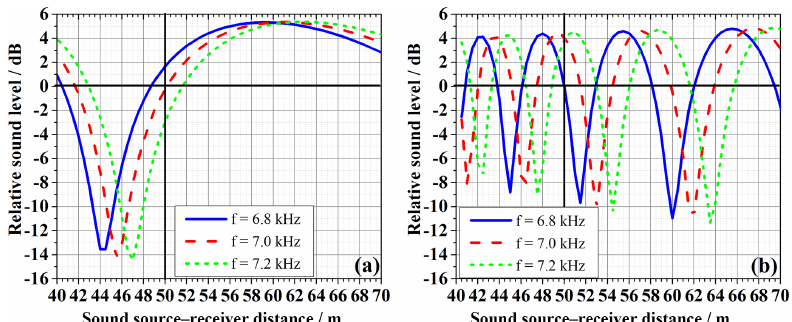
Figure 8. Relative sound level depending on the distance and on the sound frequency for a grassland surface. The height of the acoustic devices above ground is 1.5m (a) and 3.0m (b) .